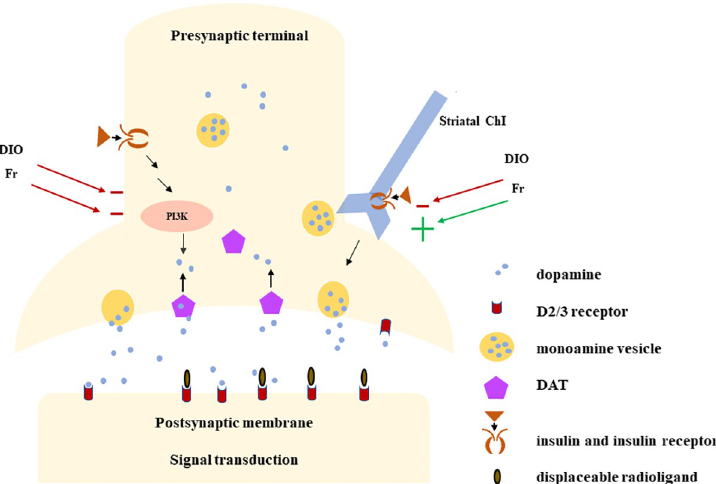
Fig 2. Presynaptic terminal: Simplified schema of insulin effects on DA neuron synapse in the striatum. Evidence supports cell surface DAT and striatal ChI excitability vary by diet-induced effects on both insulin secretion/levels and insulin sensitivity. Postsynaptic membrane: with PET imaging the displaceable radioligand competes with extracellular DA for binding.